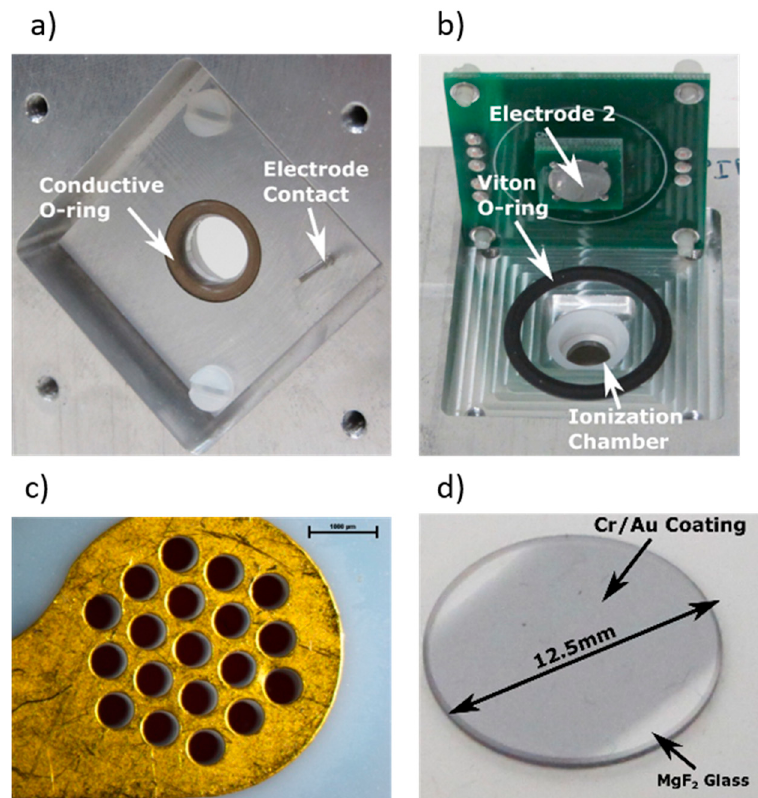
Figure 2. In-house fabricated PID ionization chamber view from ( a ) top and ( b ) bottom, and PID sensor electrode ( c ) state-of-the-art PID reference electrode, scale bar 1000 μ m and ( d ) PID reference electrode fabricated through deposition of a Cr (2.5 nm)/Au (2.5 nm) sputtered thin films.